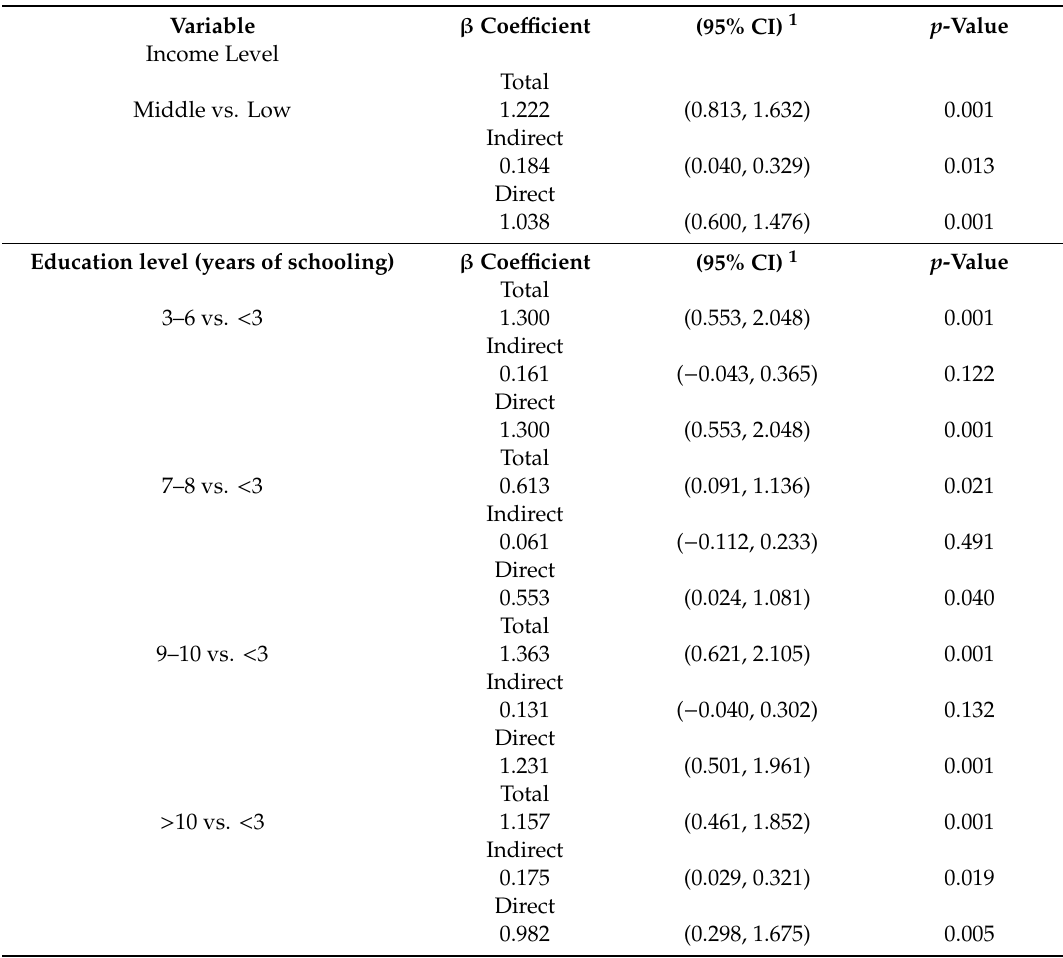
Table 5. Results of a mediation analysis of the stay-at-home COVID-19 preventive behavior, and the total e ff ects, indirect e ff ects and direct e ff ects of income level and educational level in adults ( ≥ 65 years old) in Mexico